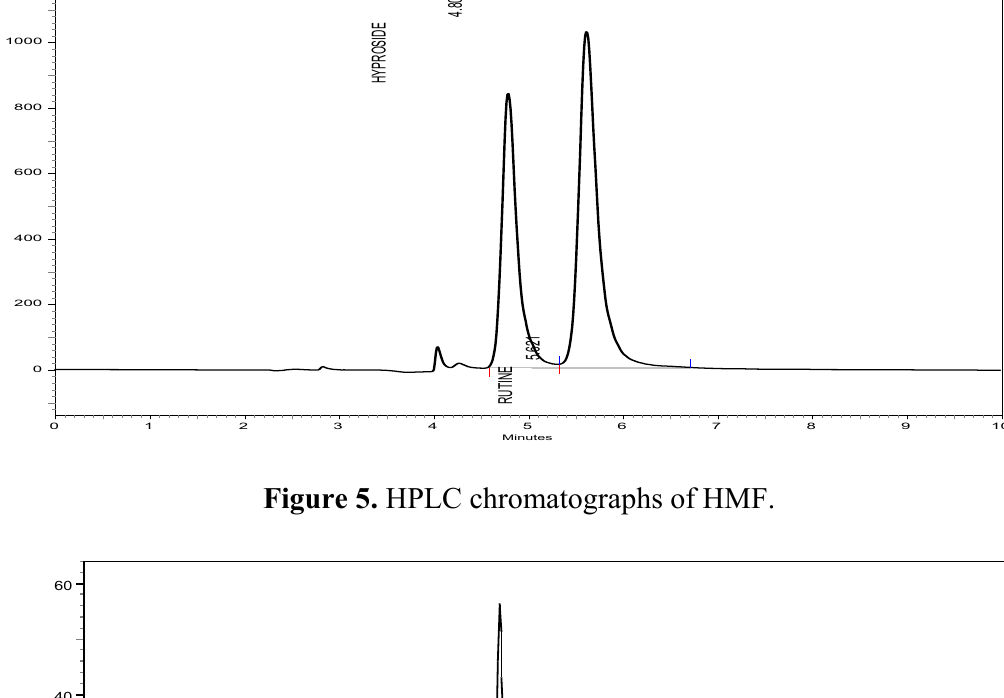
Figure 4. HPLC chromatographs of hyperoside and rutin.